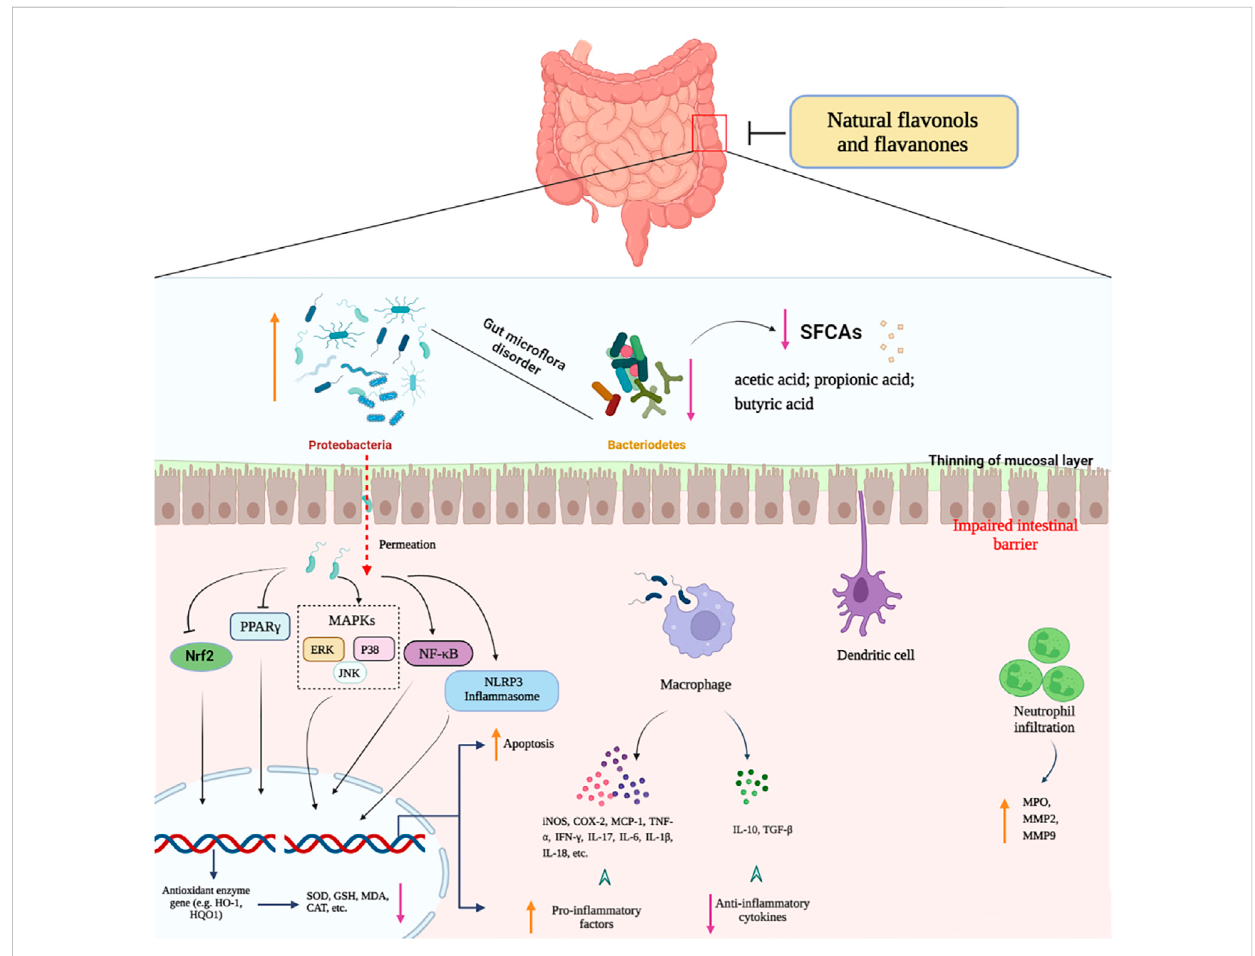
Molecular mechanisms of natural fl avonols and fl avanones in the therapy of